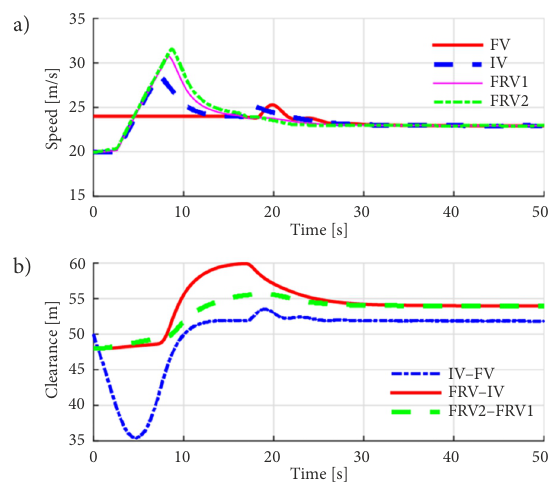
Figure 15. Speeds and clearance of vehicles considering rear-end collision escape (source: created by the authors): a – speeds of vehicles; b – clearances between vehicles; FV – following vehicle;